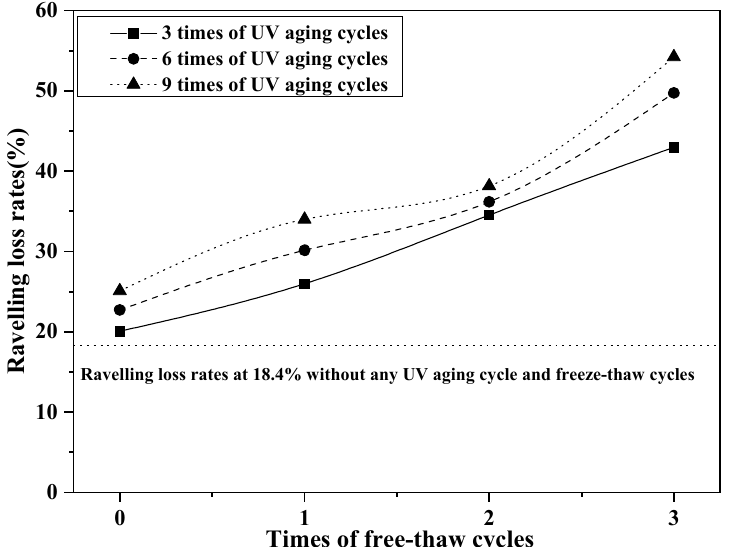
Figure 7. UV test results of the impact of the combined UV aging and freeze–thaw cycles.